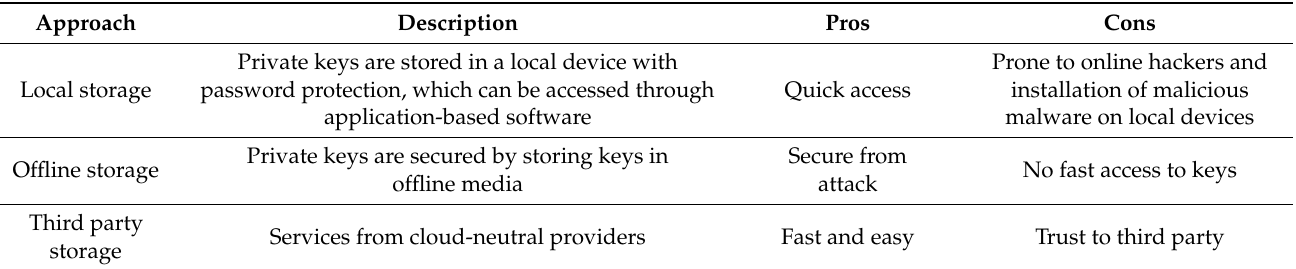
Table 2. The key management